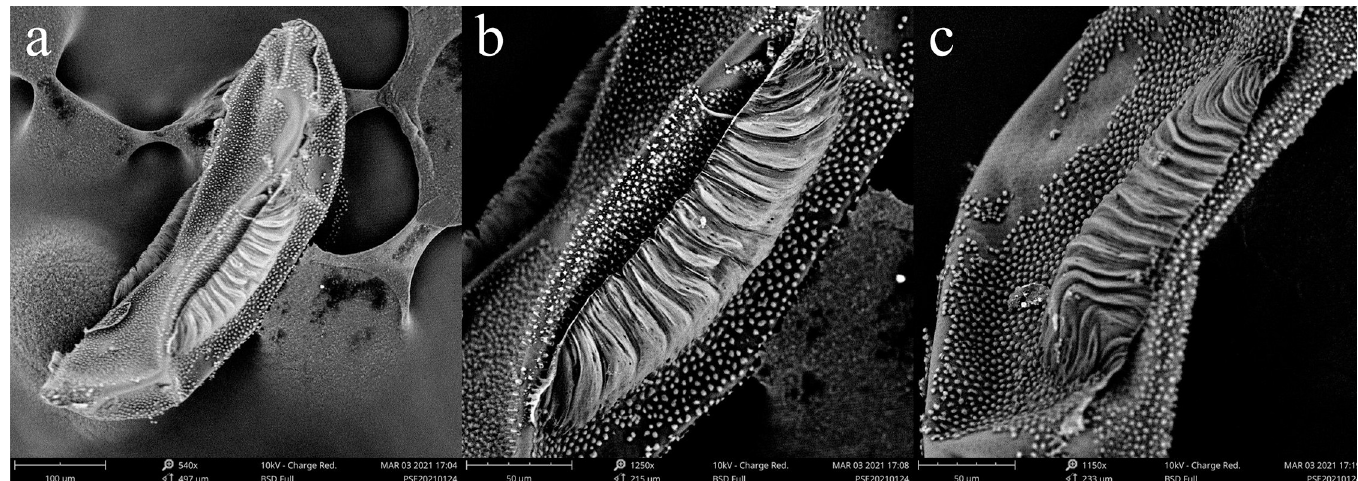
Fig 1. Scanning electron micrograph of Anopheles stephensi ‘mysorensis’ form egg: (a) Ventral aspect showing deck area (scale bar: 100 μ m); (b) Lateral aspect showing floats and ribs (scale bar: 50 μ m); (c) Lateral aspect (scale bar: 50 μ m).